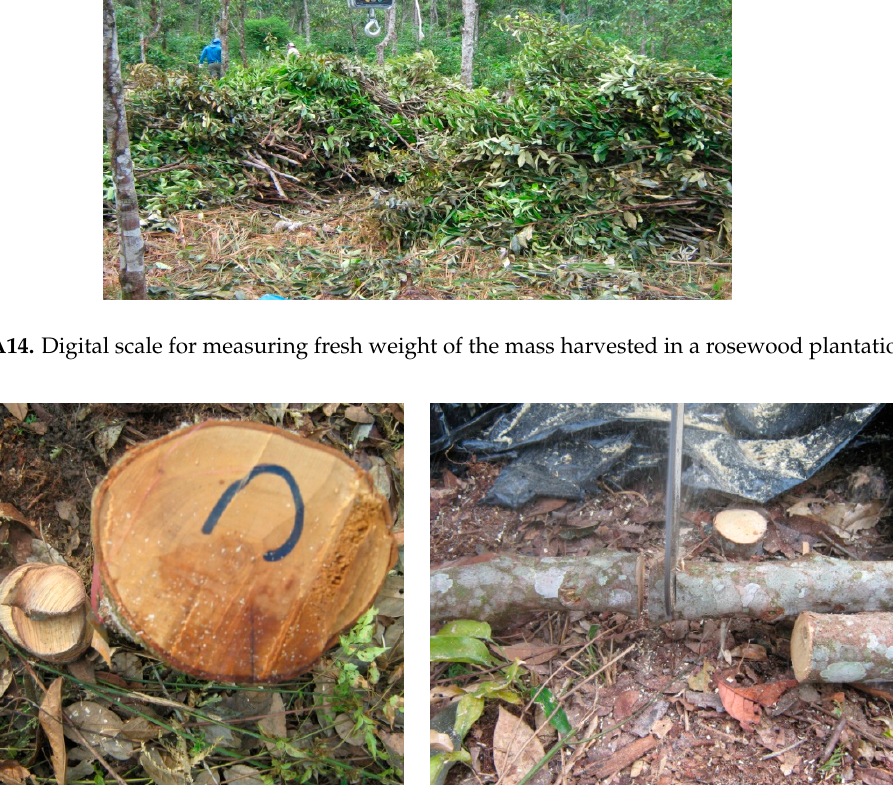
Figure A15. ( Left ) Collection of wood discs at 0%, 50% and 100% of the height of the stem and ( Right ) using chainsaws, harvesting sawdust and cutting of the trunk in sections.